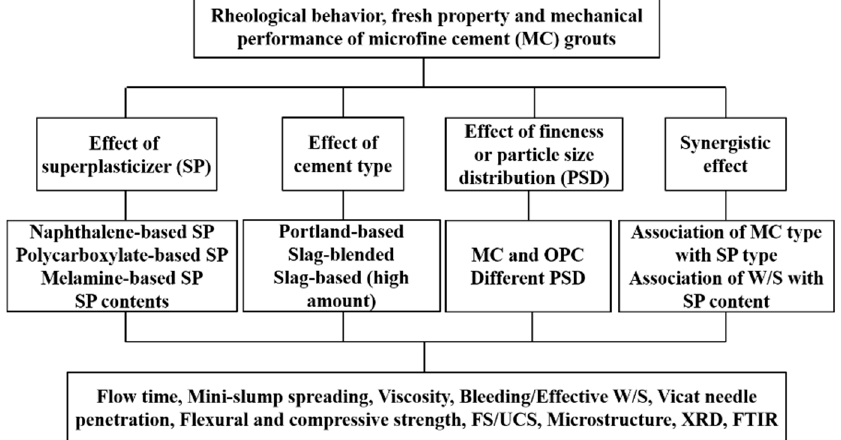
Figure 3. Experimental formulation and approach.